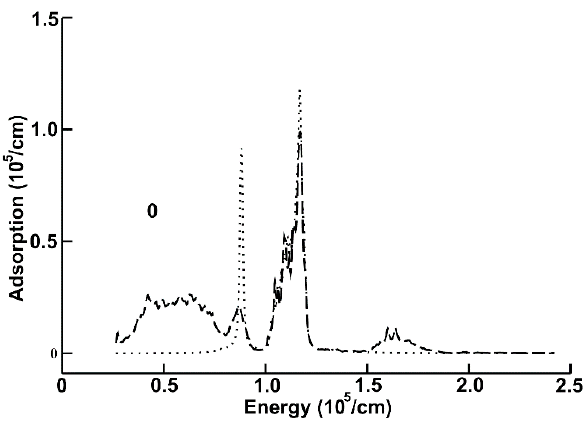
Figure 4. Absorption for the new system (dashed curve), and for the graphene layer (dotted line), for the ultraviolet region of the spectrum.